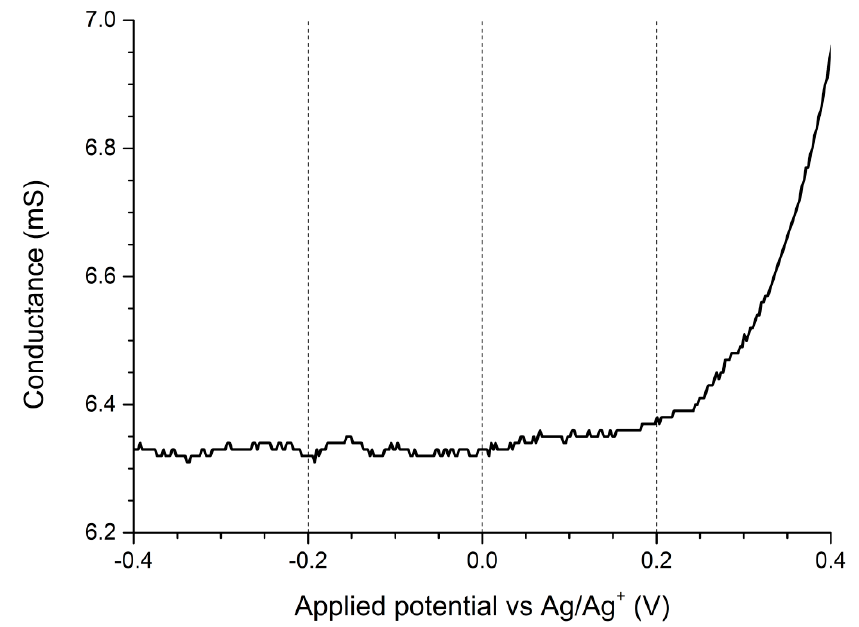
Figure A9. Zoomed in low-potential end of the voltammogram registered for double working electrode electroconductometry of regioregular P3HT film on an interdigitated Pt electrode. Potential offset between the working electrodes Δ V = 0.005 V.